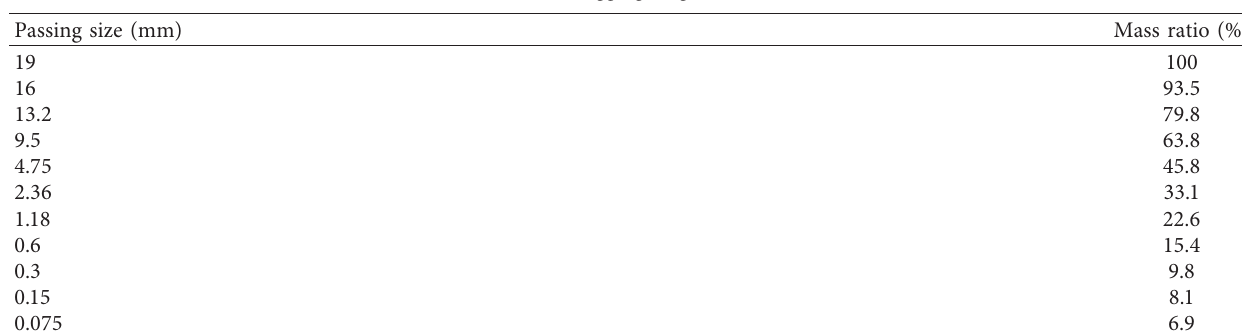
Table 4: Aggregate gradation.